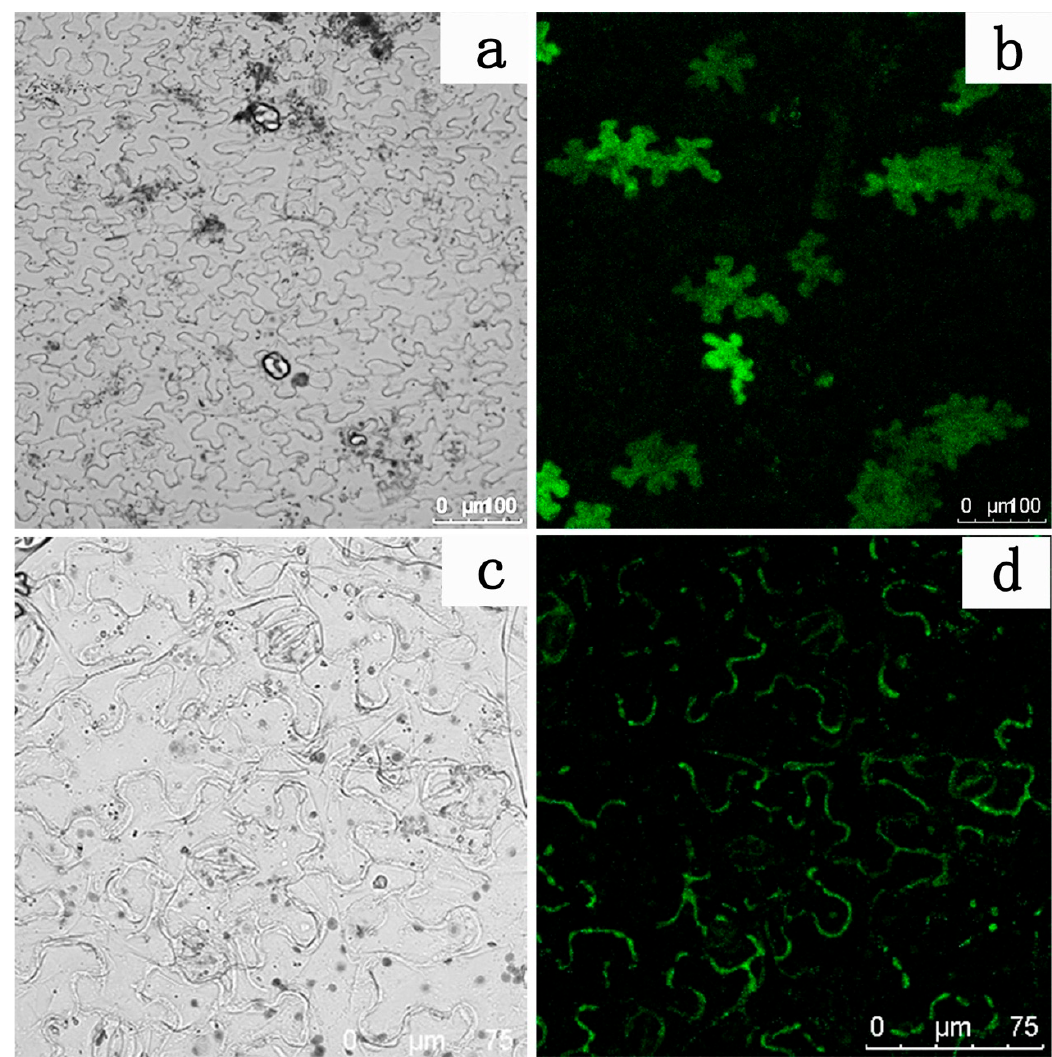
Figure 8. Subcellular localization of the LhDTX35 -GFP fusion protein. ( a , c ) Bright field images; ( b , d ) GFP fluorescence images; ( a , b ) cells expressing the LhDTX35 -GFP fusion protein; ( c , d ) cells expressing 35S::GFP as a control.